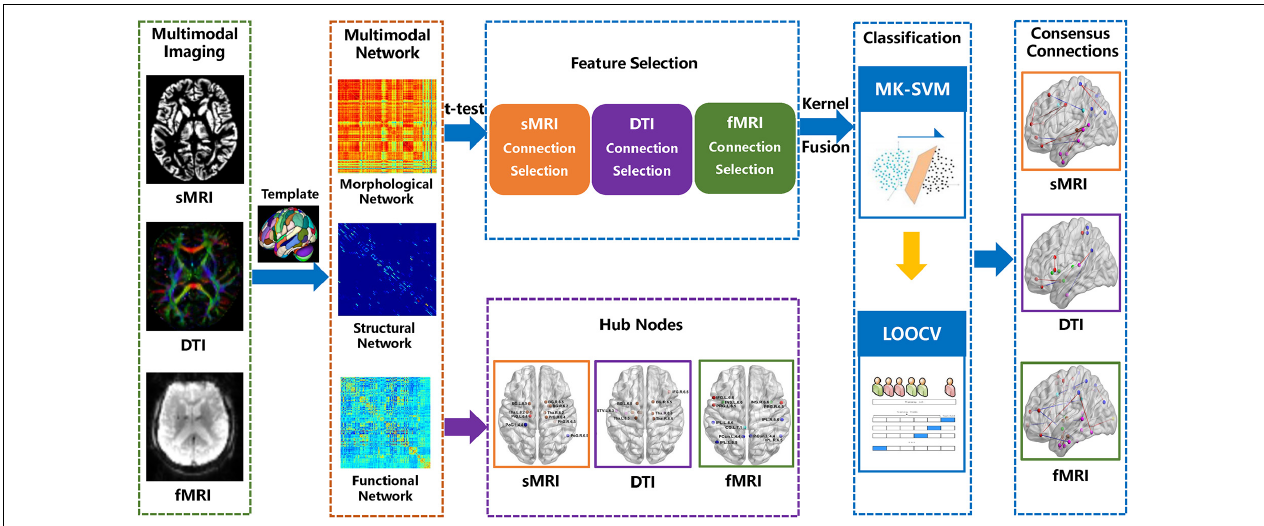
FIGURE 1 | Procedures of data processing in the present